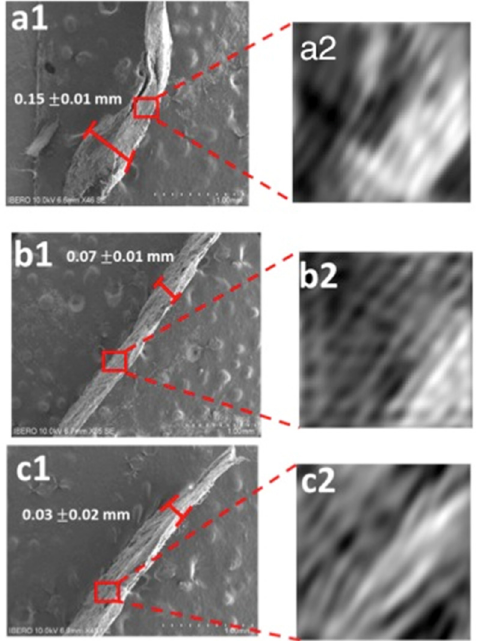
Figure 6. SEM micrographs of pericarp in different parts. Scales correspond to 1 mm. ( a1 ): The near pedicel part, ( b1 ): in middle part, ( c1 ): end part, and ( a2 , b2 , c2 ): close up of pericarp parts, images by fast Fourier transform (FFT).